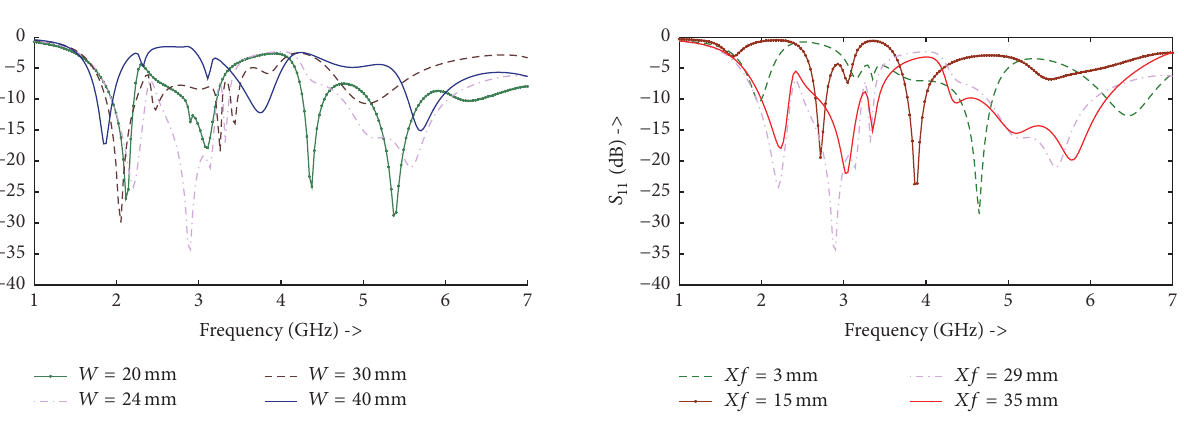
Figure 8: Reflection coefficient of different patch widths.